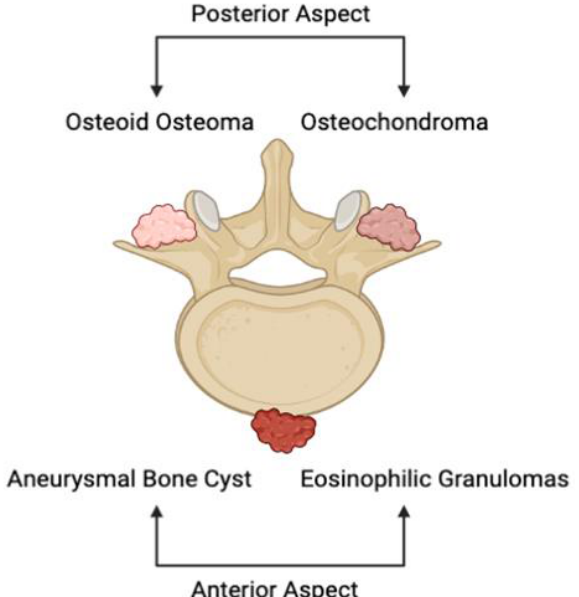
Figure 1. Illustrative depiction of the anatomical location of common primary osseous lesions of the vertebrae. Aneurysmal bone cysts and eosinophilic granulomas depict prevalent primary vertebral tumors of the anterior portion of the spine, while osteoid osteomas and osteochondromas represent lesions that represent those witnessed on the posterior portion of the vertebrae.